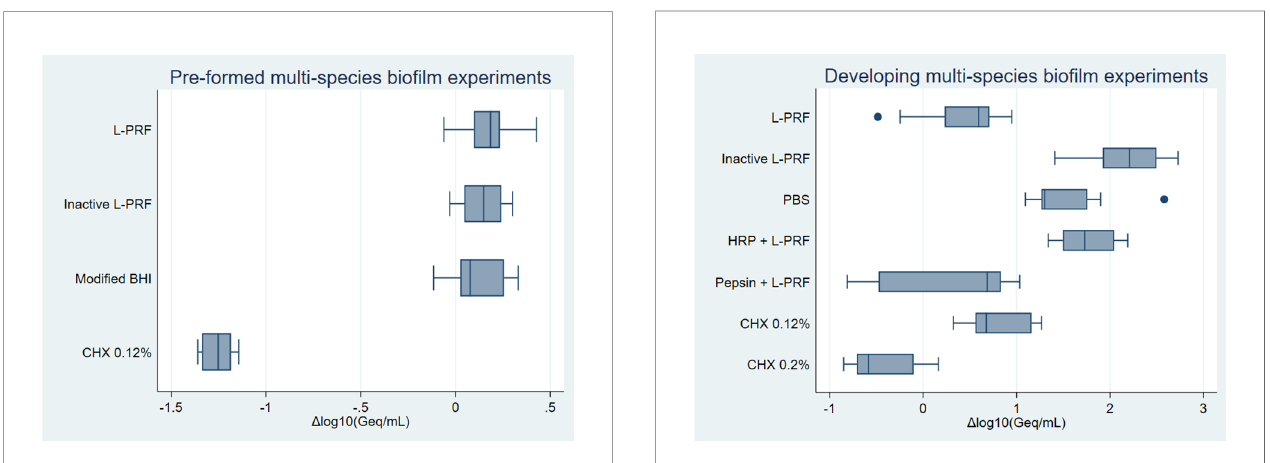
FIGURE 4 | Developing multi-species bio fi lm experiments on P. gingivalis boxplot. Negative values represent bacterial growth inhibition while positive values indicate bacterial growth. D log 10 (Geq/mL), Differences in logarithmic values of genome equivalents per millilitre; L-PRF, Leucocyte- and platelet rich fi brin; PBS, Phosphate-buffered saline; CHX, Chlorhexidine; HRP, Horseradish peroxidase.